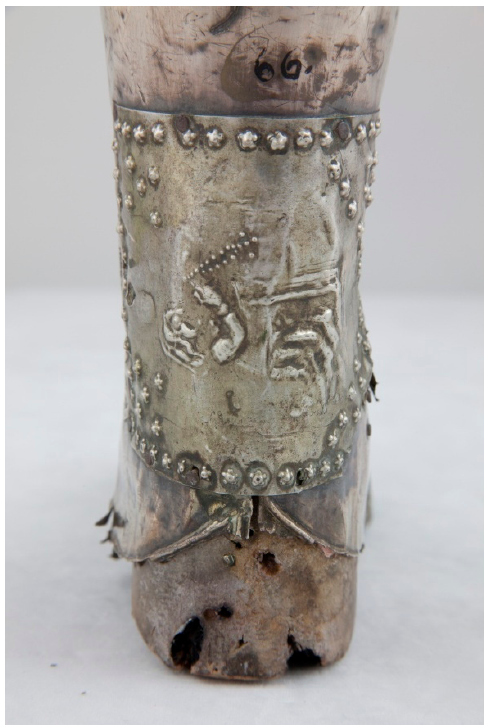
Figure 12. Leg-shaped reliquary (15th century) with ex-voto plates (18th century), Cathedral of Saint Tryphon, Kotor, photos by Stevan Kordi ć .